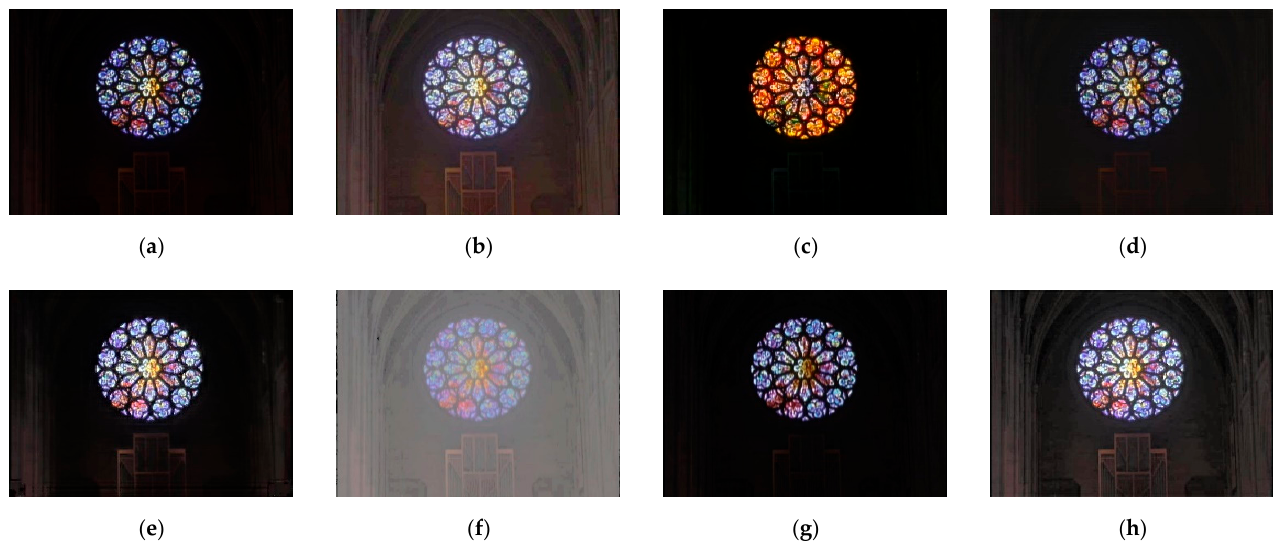
Figure 14. Dark surrounding image #2: ( a ) input, ( b ) target, ( c ) CycleGAN, ( d ) Lum CycleGAN, ( e ) EV GAN, ( f ) HDRCNN, ( g ) ExpandNet, and ( h ) the proposed model.